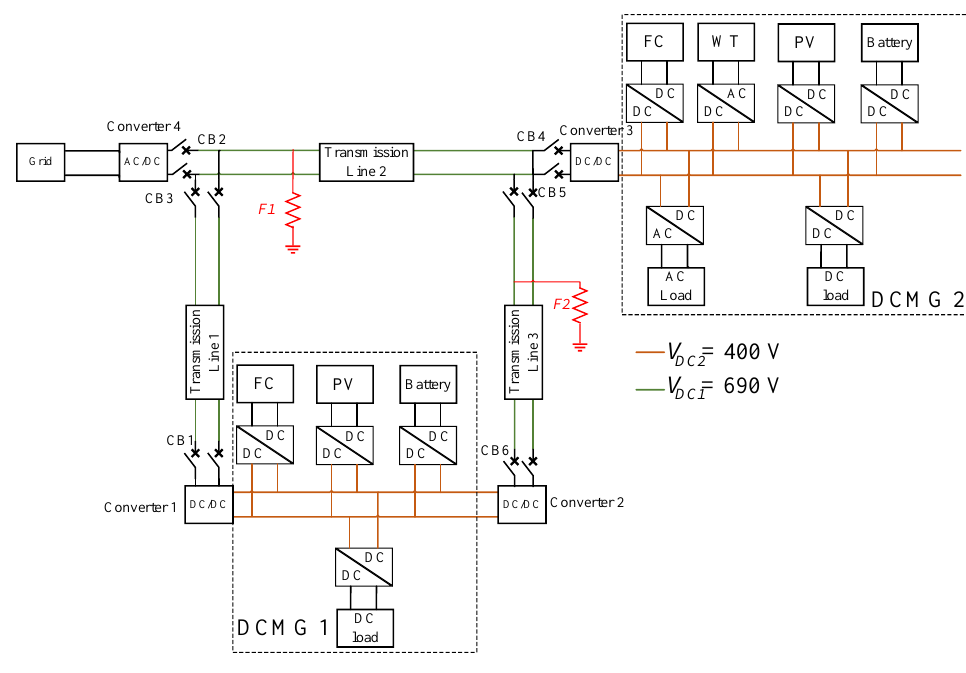
Figure 1. Structure of a DC MG cluster. Table 2. Main parameters of the case study.